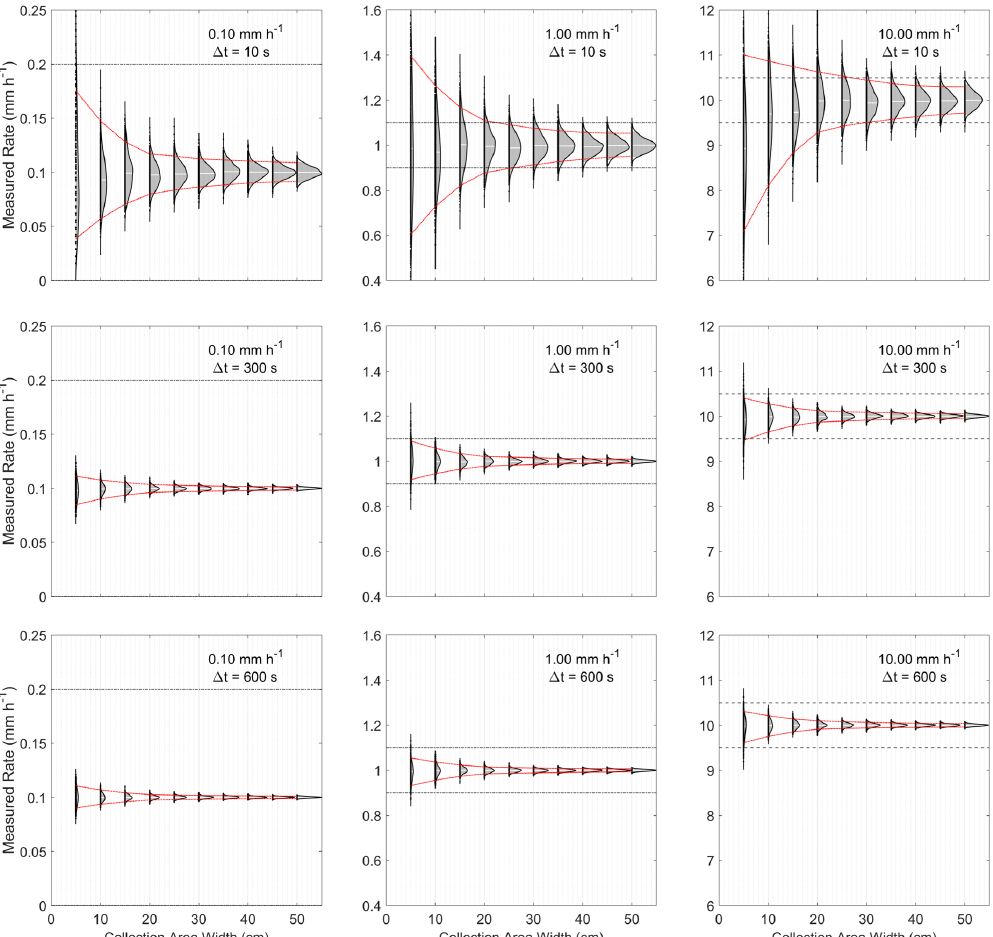
Figure 3. Comparison of R = 0.10, 1.00, and 10.00mmh − 1 for (cid:49)t = 10s, 5min, and 10min. The applicable WMO standards for each rate ( ± 5%, dashed, and ± 0.1mmh − 1 , dot-dashed) are shown as horizontal